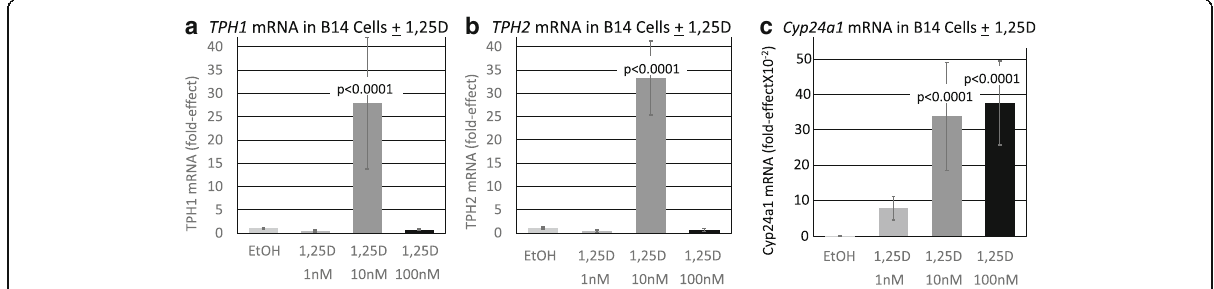
Fig. 4 Effect of 1,25D on TPH1, TPH2 and Cyp24a1 mRNAs in a serotonergic neuronal cell line. P values listed at the top of bars represent statistical significance for comparison between 1,25D-treatment and ethanol vehicle control group in each and all cases. Statistical analyses were performed using ANOVA with a post hoc adjustment of P values via the Dunnett test that compares every mean to a control mean and takes into account the scatter of all the groups. a Expression of TPH1 in serotonergic rat raphe RN46A-B14 cells treated with 1,25D. The exact fold-effect values for 1 and 100 nM 1,25D are too small to be perceived in the figure as scaled; they are 0.41 ± 0.22 and 0.73 ± 0.17, respectively. Each mRNA value is the average of nine biological replicates ± std. dev. b Expression of TPH2 in serotonergic rat raphe RN46A-B14 cells treated with 1,25D. The exact fold-effect values for 1 and 100 nM 1,25D are too small to be perceived in the figure as scaled; they are 0.36 ± 0.23 and 0.65 ± 0.31, respectively. Each mRNA value is the average of 30 biological replicates ± std. dev. c Expression of Cyp24a1 in serotonergic rat raphe RN46A-B14 cells treated with 1,25D. Each mRNA value is the average of 20 biological replicates ± std.